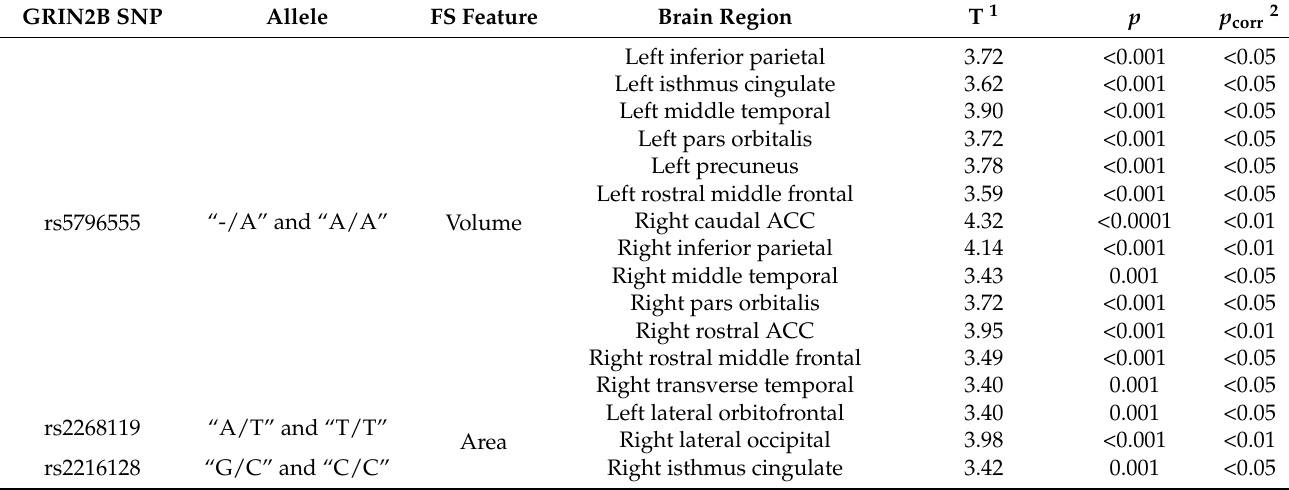
Table 3. General Linear Model results of GRIN2B markers effect on brain morphological parameters.